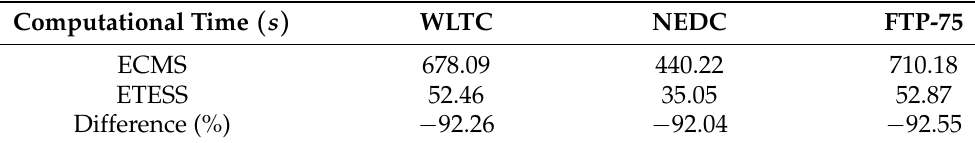
Table 5. Comparison between the computational time (in MIL testing) of ETESS and ECMS along three type-approval driving